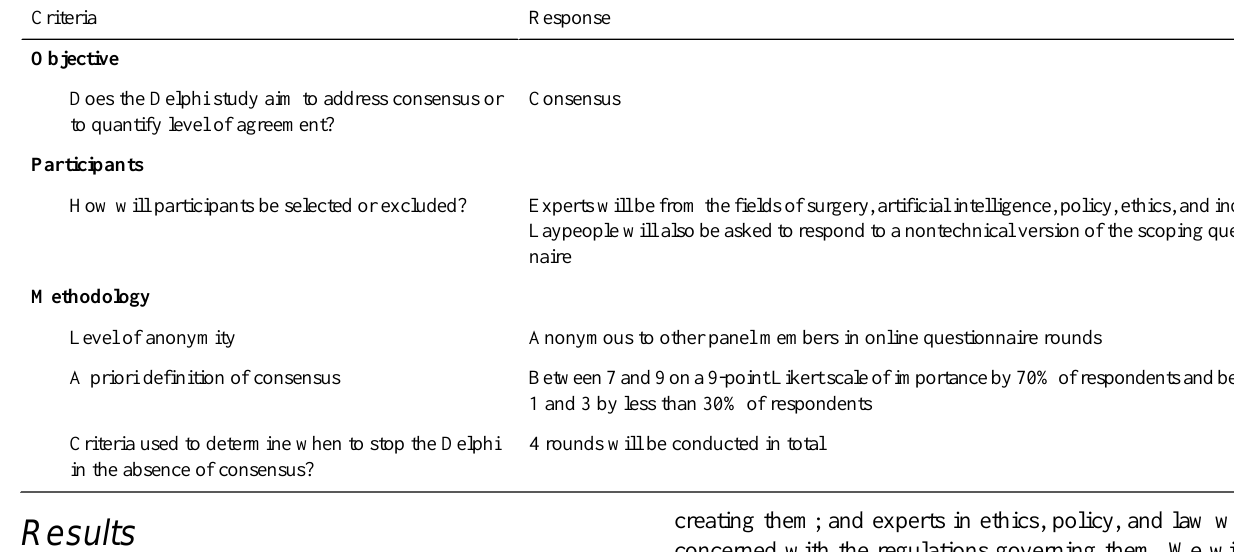
Table 1. Key methodological criteria for reporting of Delphi studies as per Diamond et al